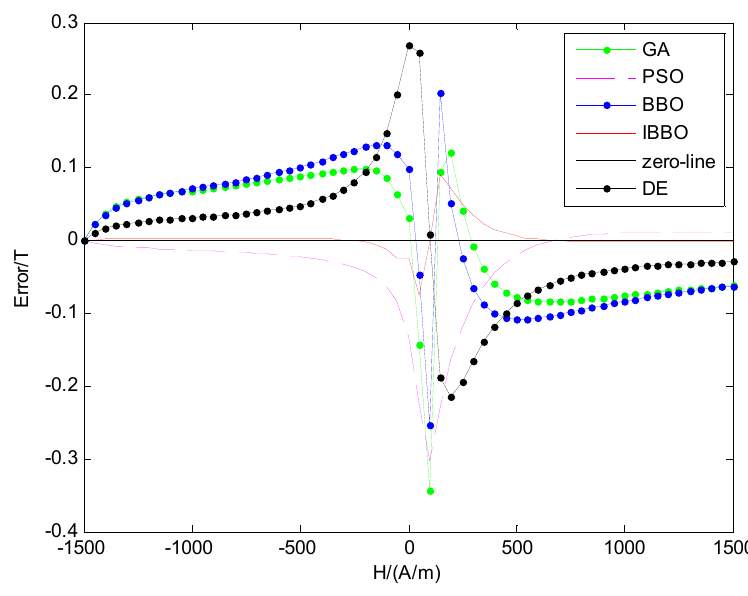
Figure 6. Errors of five methods on ascending part.